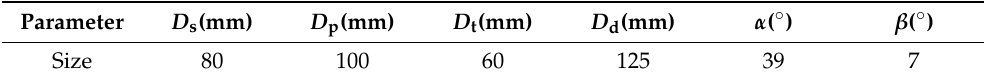
Table 1. Structural parameters of jet fish